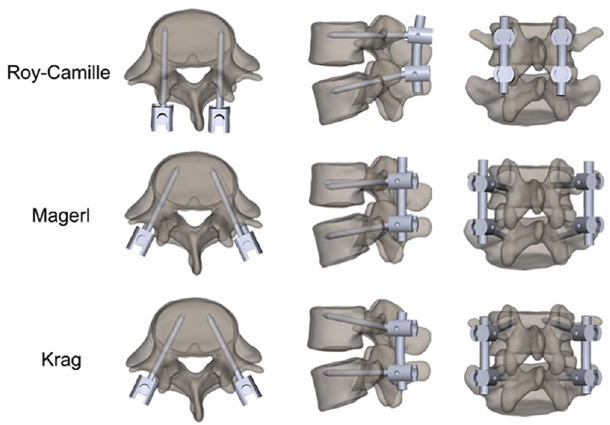
Figure 1. The methods of three pedicle screw insertion techniques. From top to bottom, they are Roy-Camille, Magerl, and Krag,